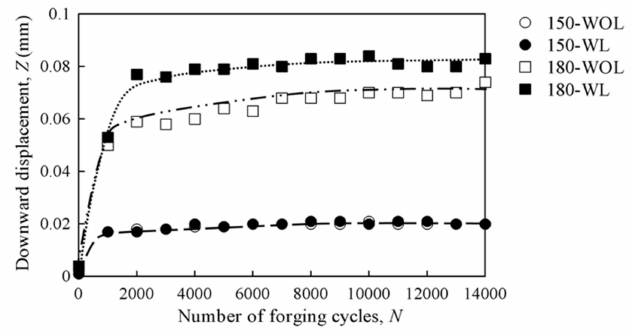
Figure 11. Variation in the downward displacement by number of forging cycles. (150 / 180—Forging load (kN), WL—With Lubrication, WOL—Without Lubrication).